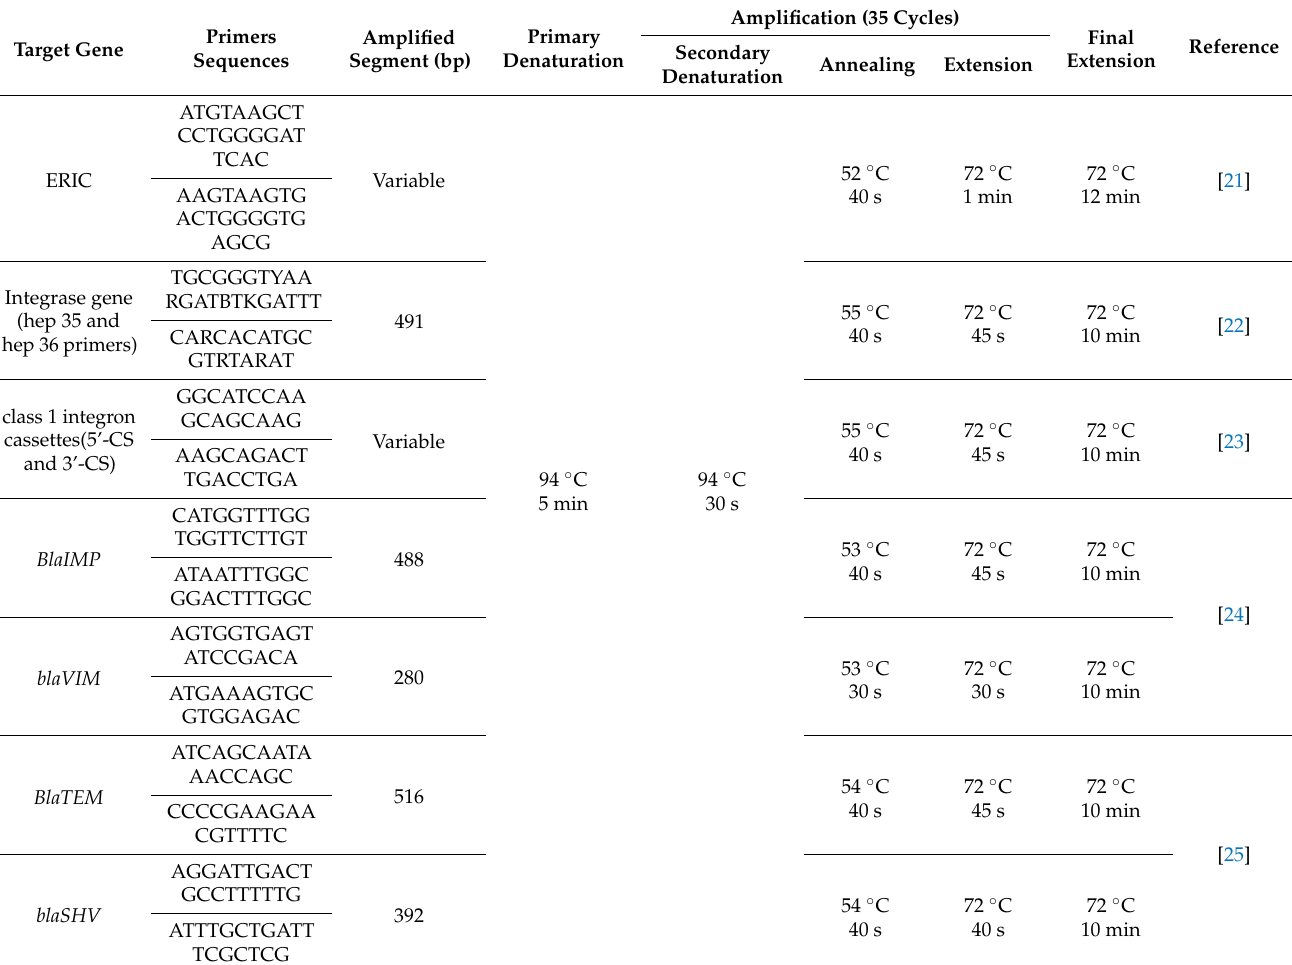
Table 2. Sequencing of primers, target genes, sizes of amplicons, and cycling